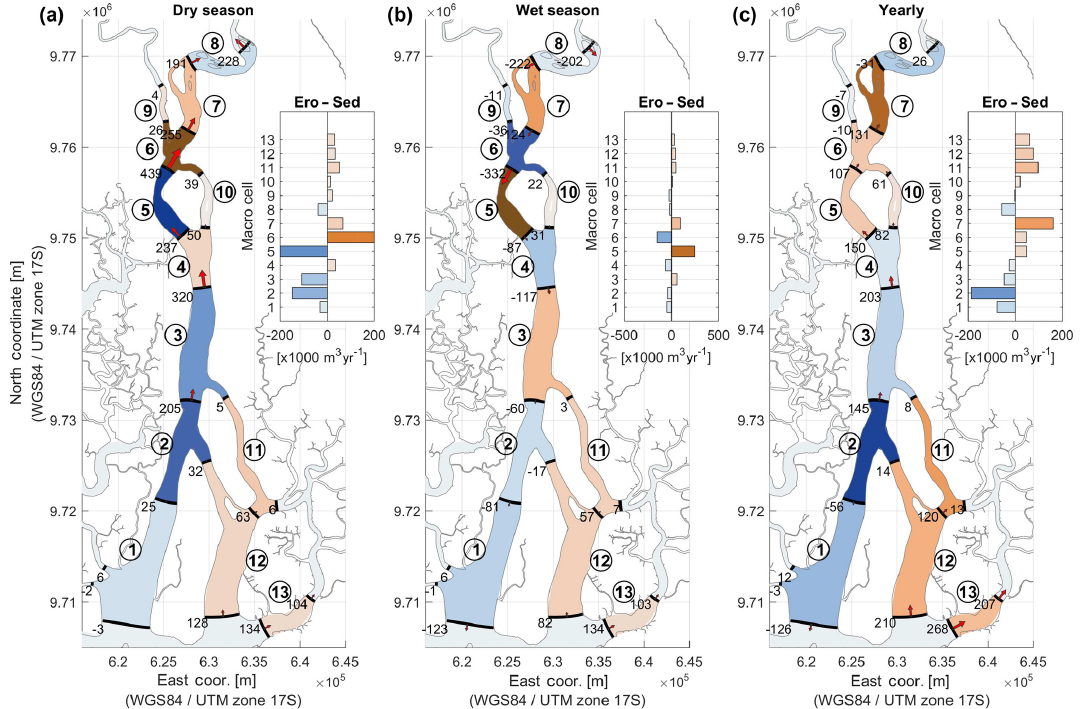
Figure 8. Sediment balance computed for the dry season (a) , wet season (b) , and full year (c) . Upstream sediment transport is considered positive whereas downstream transport is negative. The circle-enclosed numbers stand for the tag assigned to each of the macro-cells. The numbers beside each transect quantify the actual sediment volume exchange between the cells ( × 1000m 3 year − 1). The overall sedimentation and erosion volumes for each macro-cell are displayed as a bar